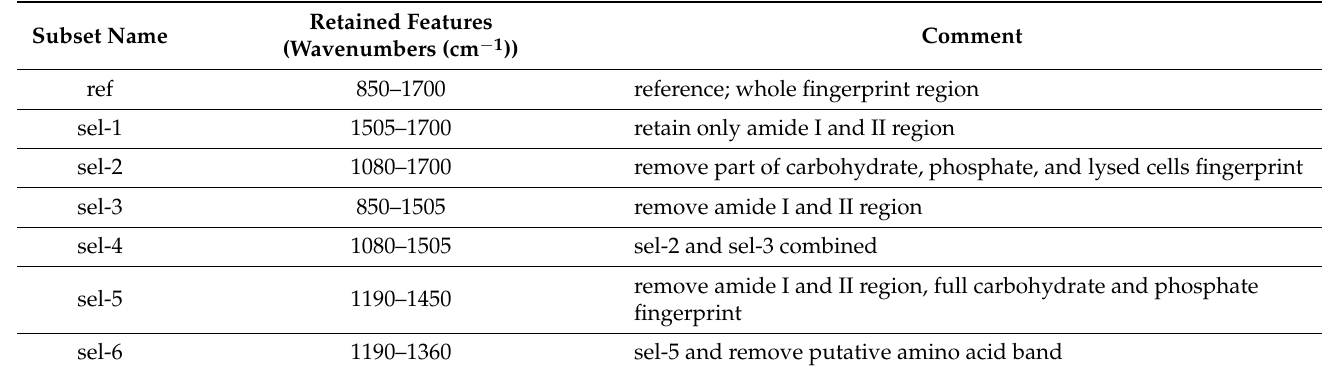
Table 1. Feature selection